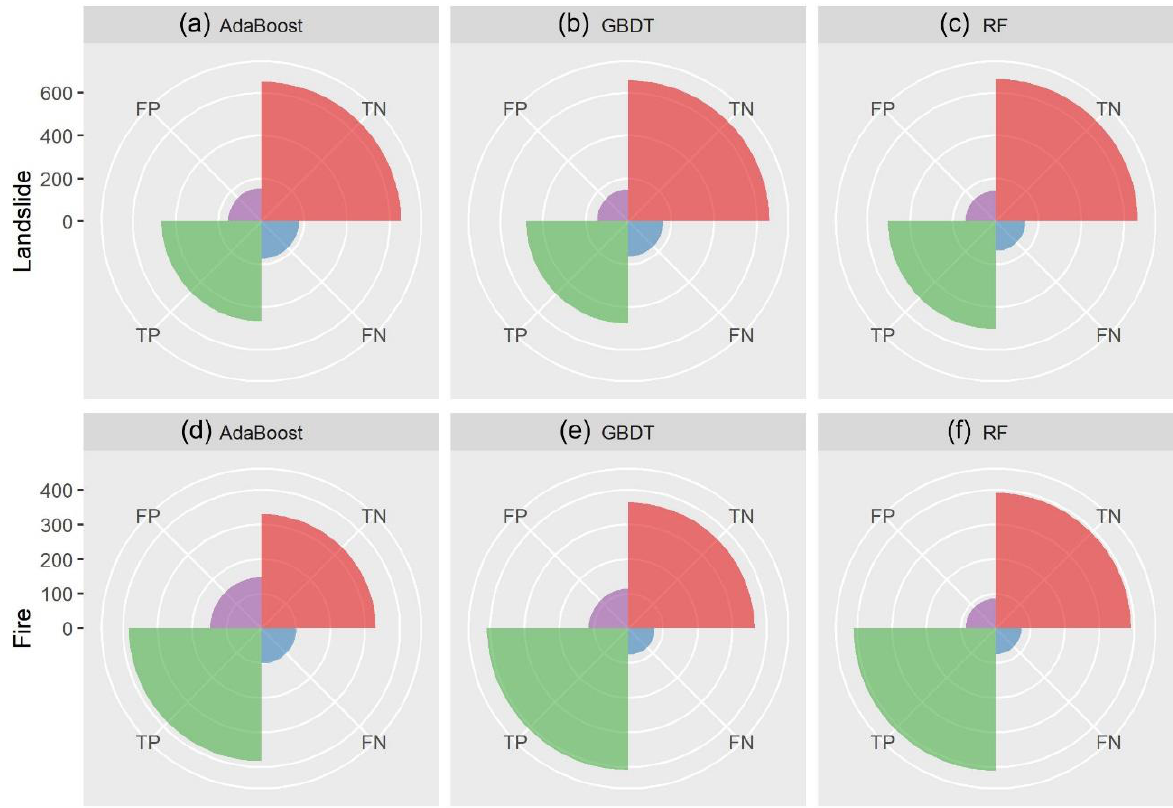
Figure 4. Contingency plots summarizing the confusion matrix values, ( a – c ) landslides and ( d – f ) wildfires.